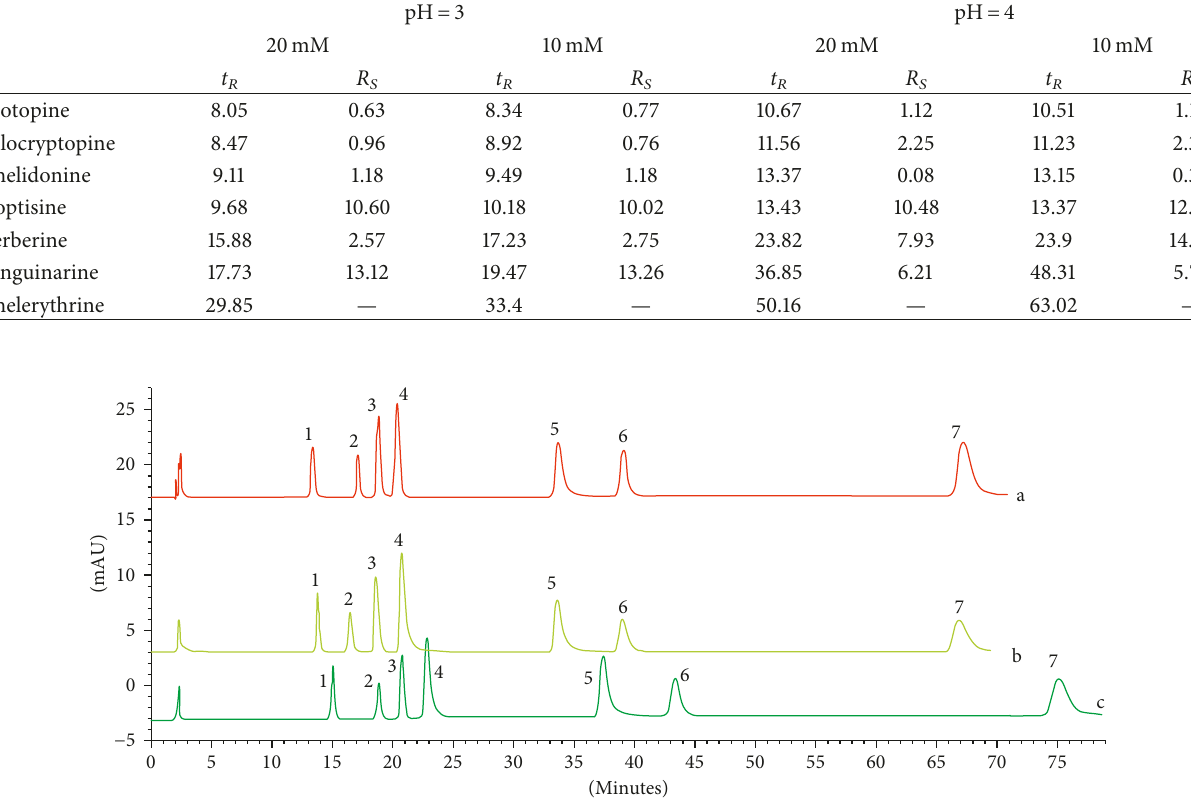
Figure 2: Exemplary chromatograms of the standard mixture obtained at (a) acetonitrile and 10 mM water solution of ammonium formate adjusted to pH 4 with formic acid (20: 80, v/v), (b) acetonitrile and 20mM water solution of ammonium acetate adjusted to pH 4 with acetic acid (20:80, v/v), and (c) acetonitrile and 10 mM water solution of ammonium acetate adjusted to pH 4 with acetic acid (20 :80,